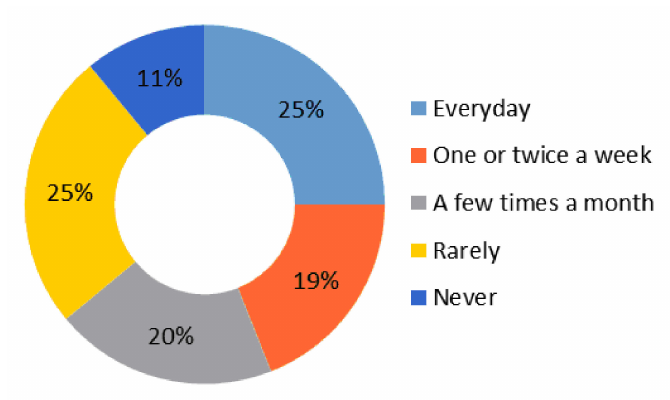
Figure 3. How often do you read?